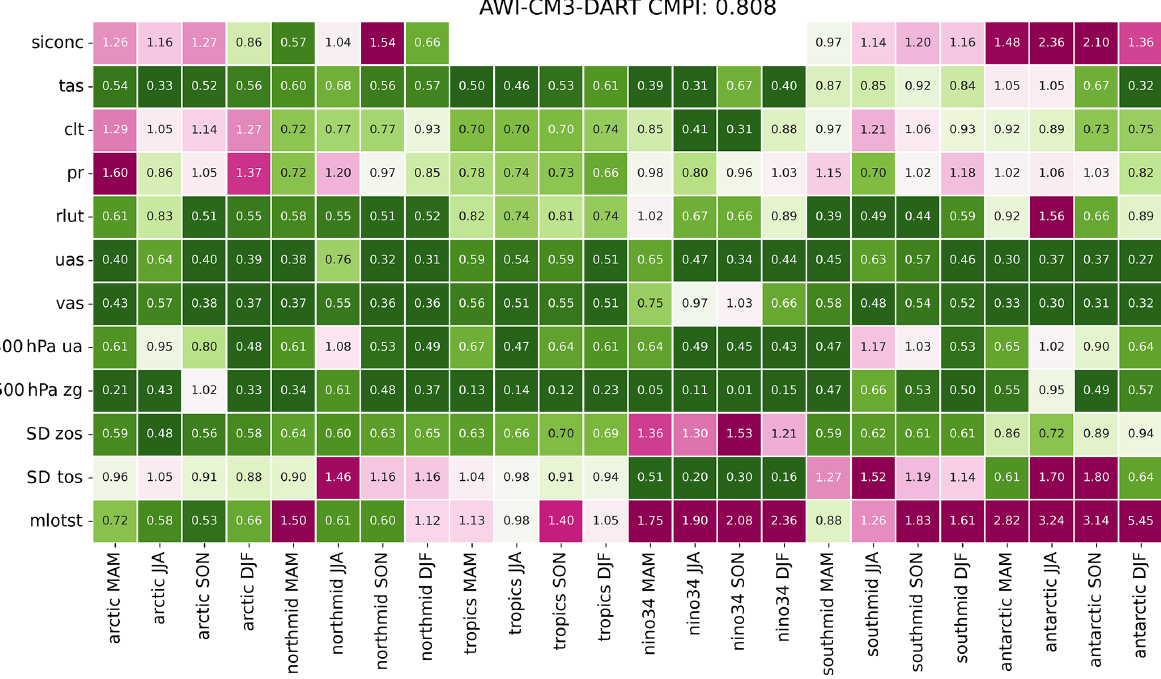
Table 4. Same as Table 1 but for the last 10 years of a 50-year-long TCo319L137-DART simulation under constant 1990 forcing. Biases compared to observations are not only smaller than in our TCo159L91-CORE2 simulations but also smaller than those of all but